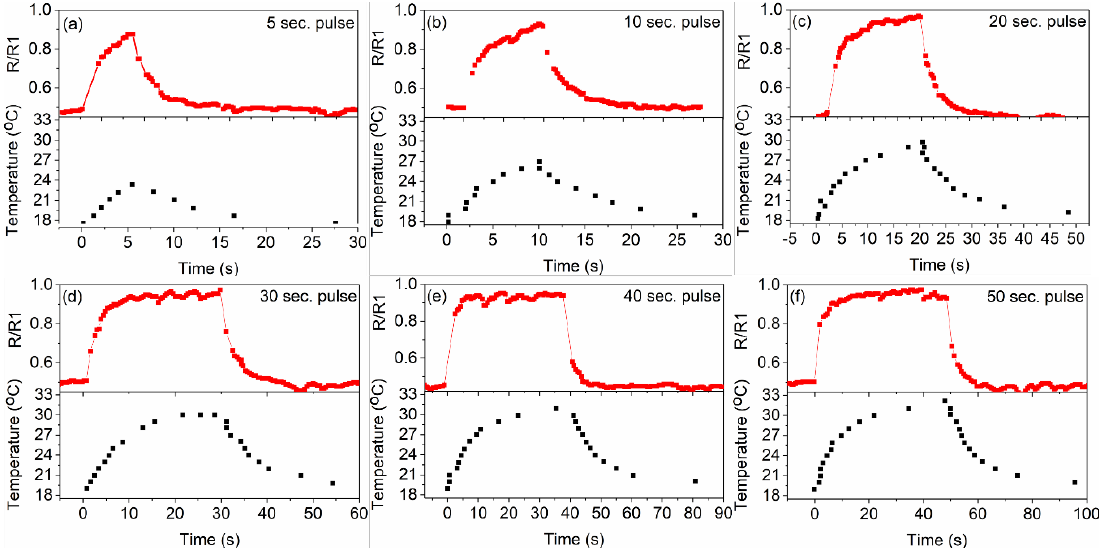
Figure 4. (a–f) Change in the normalized resistance and temperature of the VAGs with time for different duration (5 s, 10 s, 20 s, 30 s, 40 s and 50 s) of IR pulses in respective graphs.